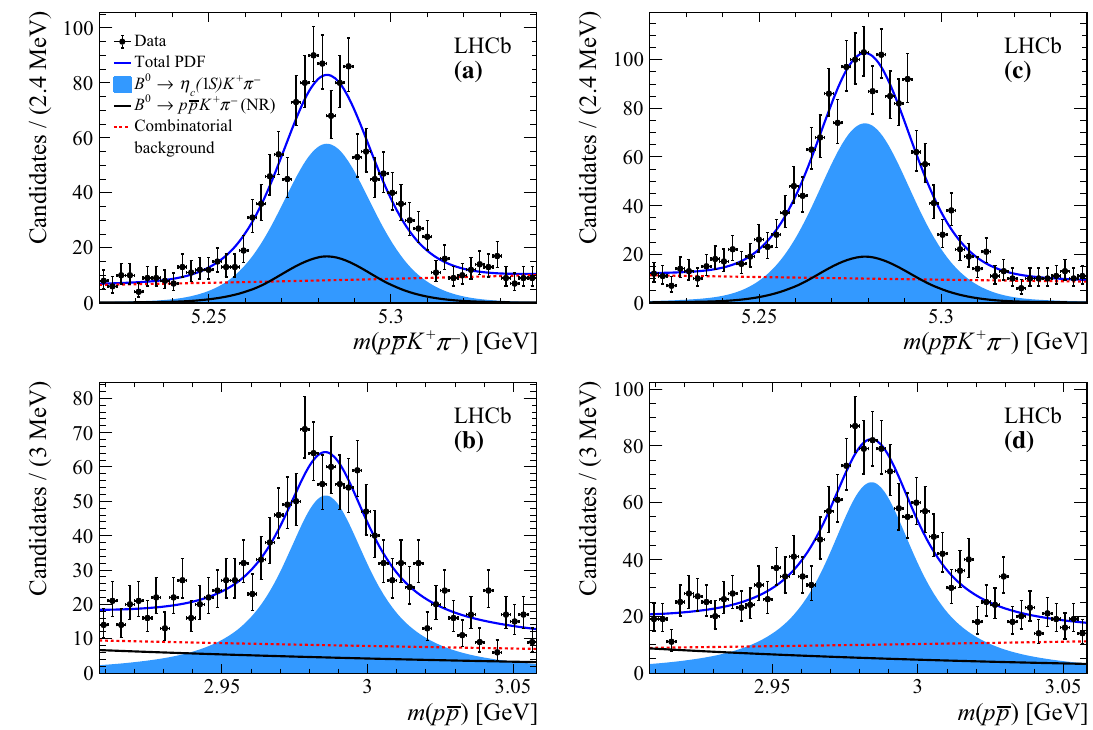
Fig. 4 Results of the 2D mass fit to the joint [ m ( ppK + π − ) , m ( pp ) ] distribution for the a Run 1 m ( ppK + π − ) projection, b Run 1 m ( pp ) projection, c Run 2 m ( ppK + π − ) projection, and d Run 2 m ( pp ) projection. The legend is shown in the top left plot